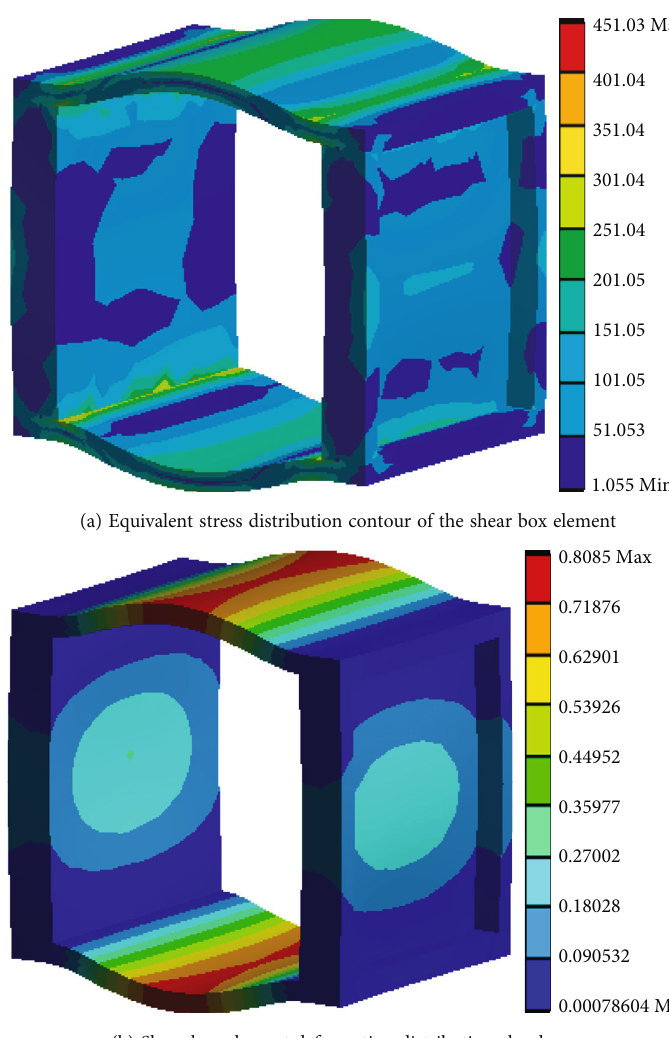
Figure 8: Numerical simulation of shear box element.